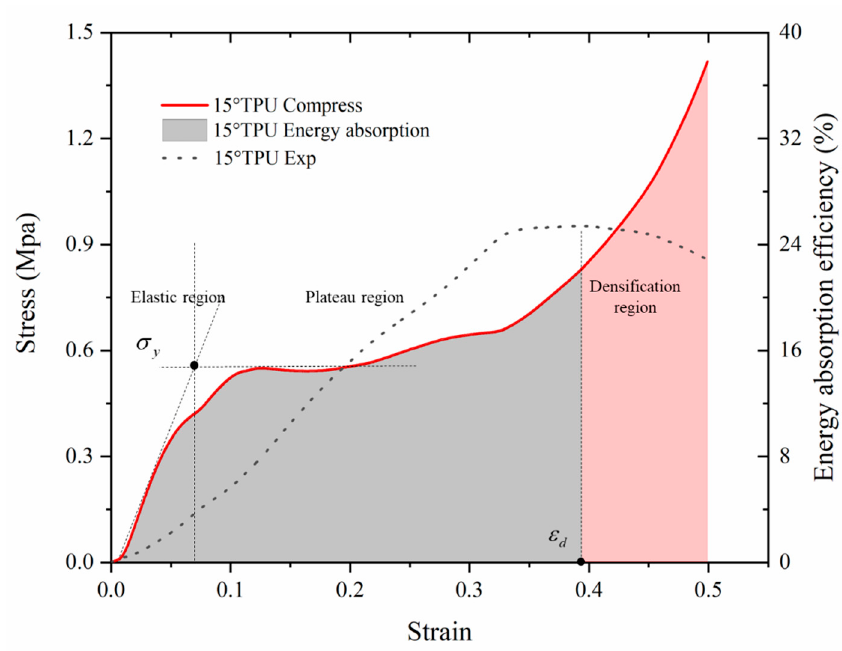
Figure 11. The stress-strain curve and energy absorption efficiency of 15 degrees TPU model.